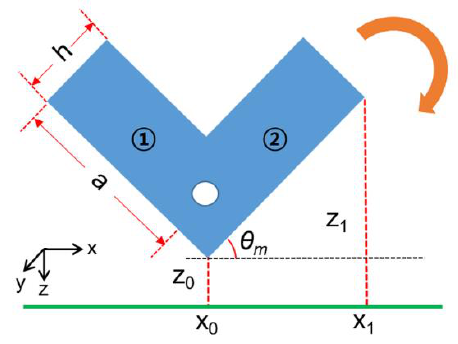
Figure 7. A schematic diagram for mathematical modeling. Table 1. Experimental data of sl2.